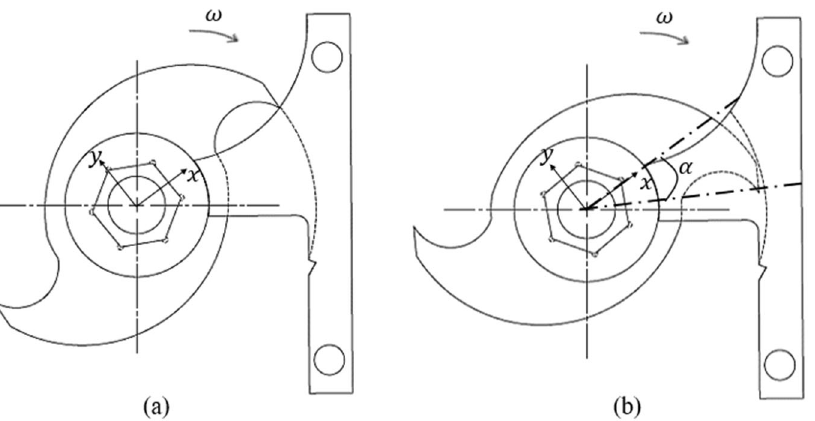
Figure 6. Definition of the offset angle α . ( a ) Shredder blade with offset angle, α = 0 and ( b ) Shredder blade with offset angle, α .